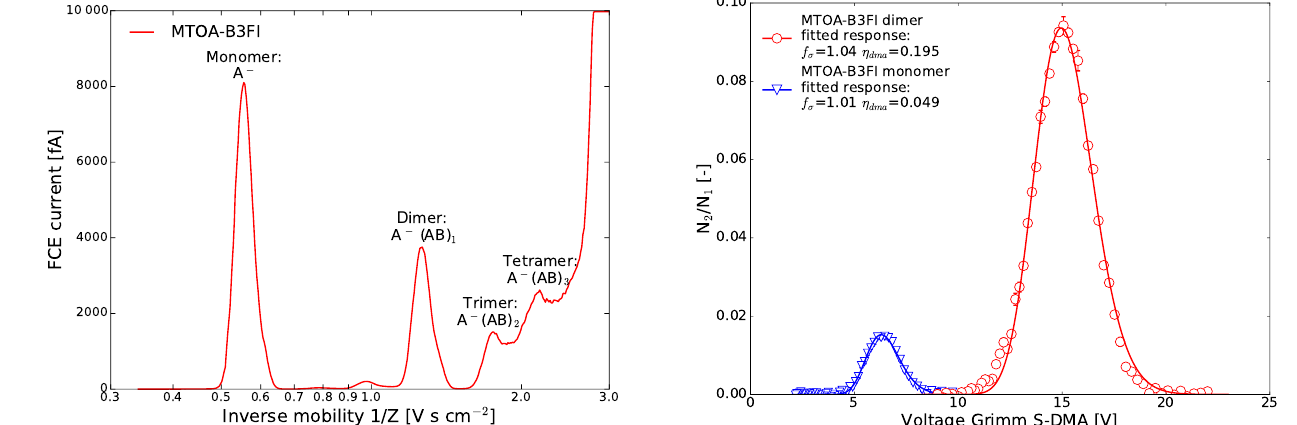
Figure 4. Typical MTOA-B3FI spectrum as recorded by a FCE downstream of the UDMA. The peaks of the monomer and dimer are clearly visible and well separated. The trimer and tetramer can be identified as well but are overlapped by a background of multiply charged larger clusters.